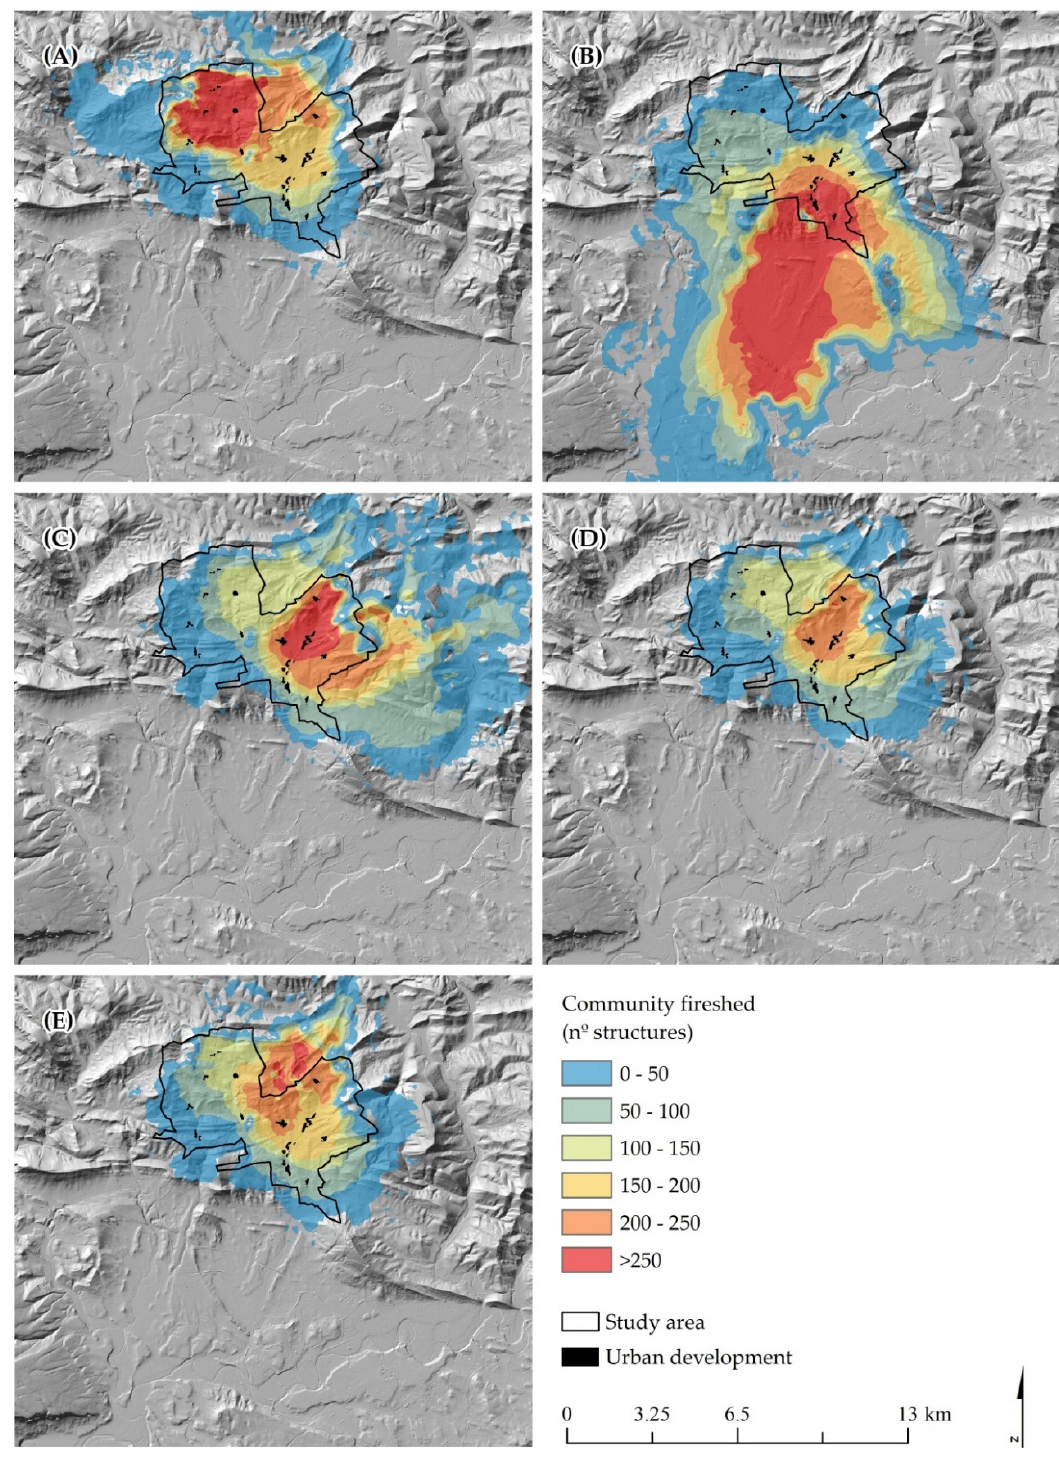
Figure 7. Community fireshed maps corresponding to the number of residential houses burned for the five wildfire scenarios. The letters from A to E indicate respectively the fire modeling wind direction scenarios of 337°, 180°, 67°, 45° and 22° (Table 2). Fireshed values were generated using a 1 ‐ km constant width radius spherical semivariogram model kriging analysis from the transmission values (TFS) assigned to fire ignition locations. Values indicate the number of structures affected by ignitions in a given pixel. Fires were simulated for 97th percentile fire weather conditions and 6 ‐ hour duration.